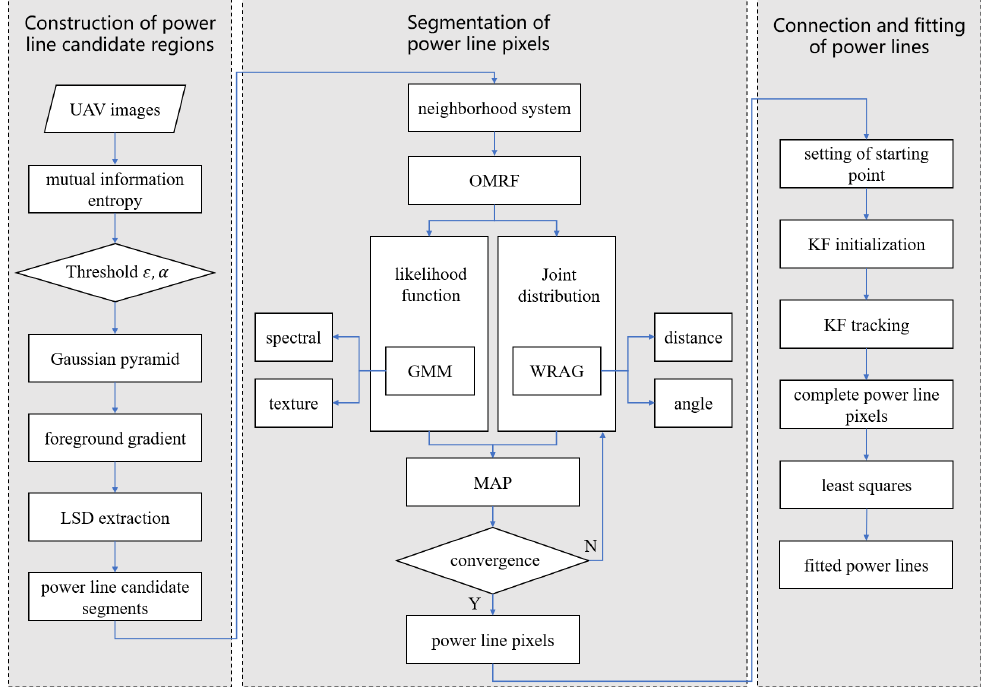
Figure 3. Technical flow chart of power line extraction.